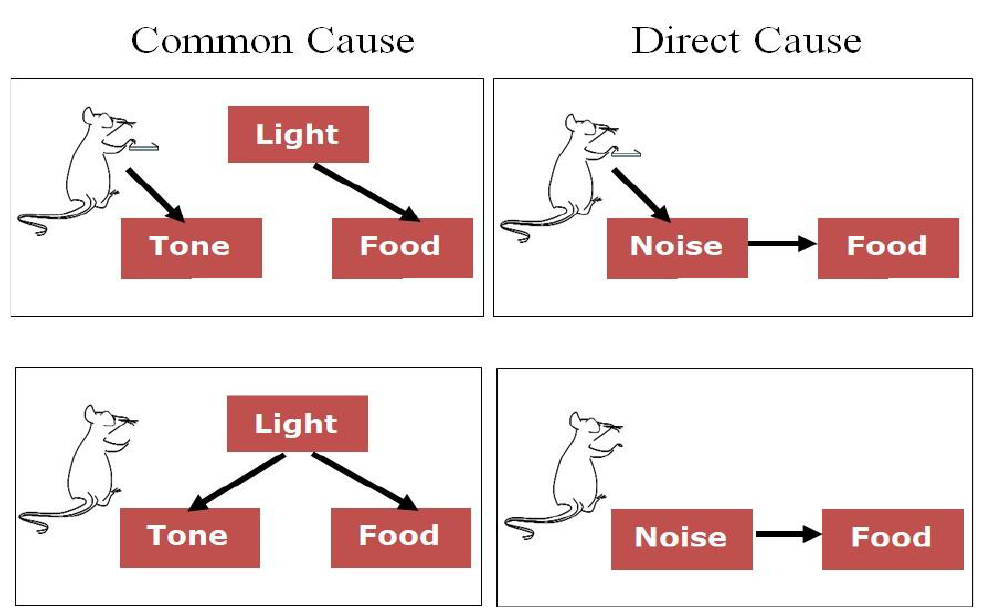
Figure 1 . Predictions of causal model theory for each test condition of Blaisdell et al. (2006), Experiment 1: Common cause intervene (top-left panel), Common cause observe (bottom-left panel), direct cause intervene (top-right panel), and direct cause observe (bottom-right panel). Causal